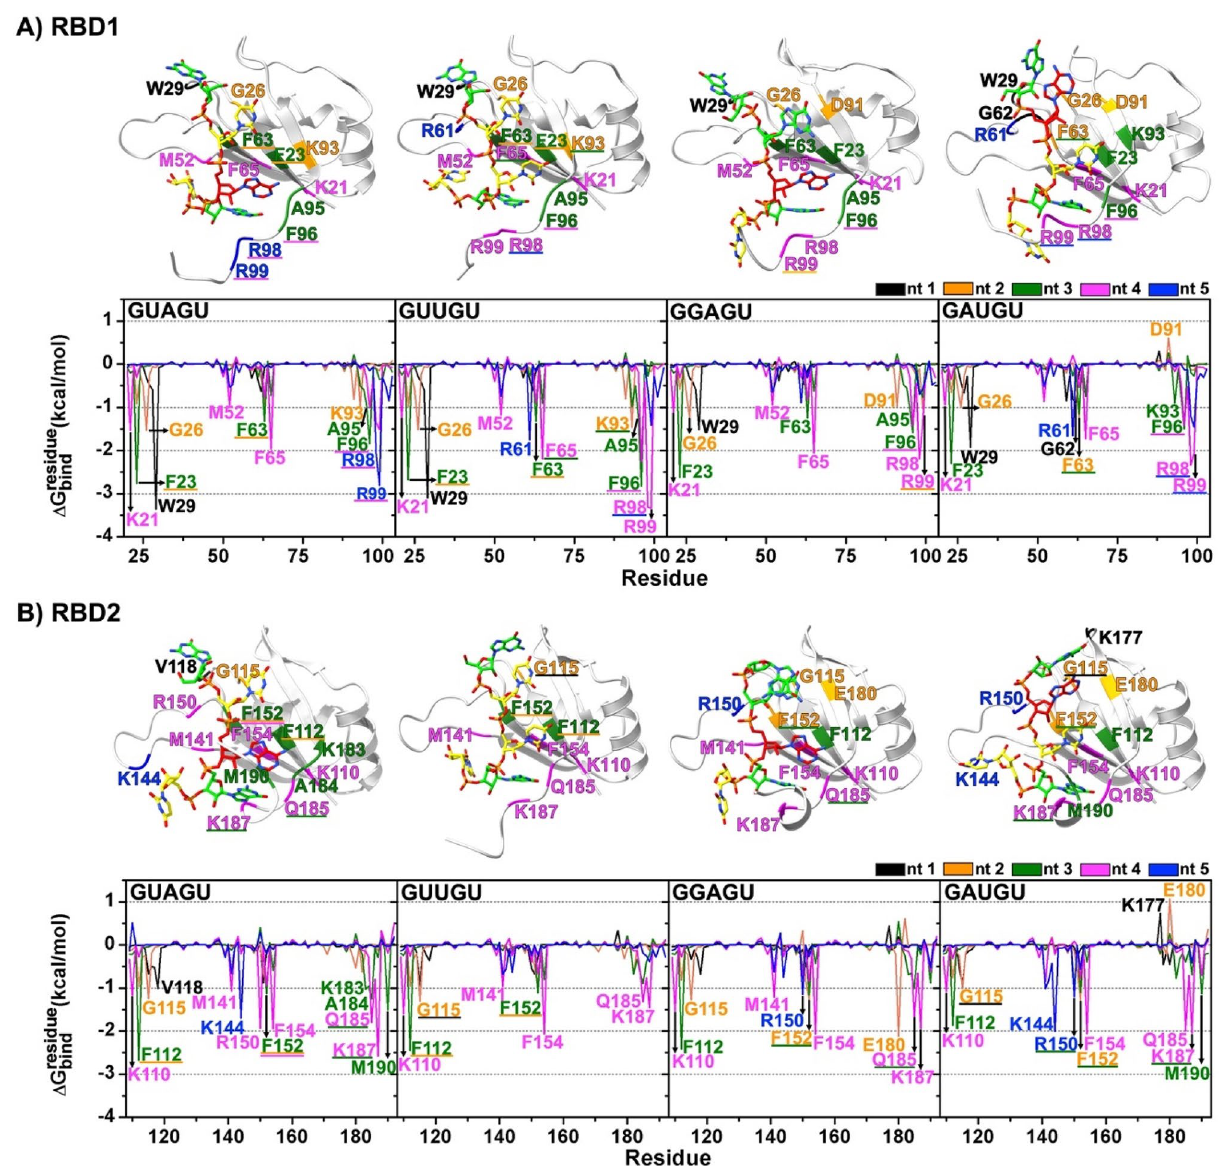
residue bind ) for the five nucleotides (nt1–nt5) of residue bind ) ≤ − 0.90 kcal/mol